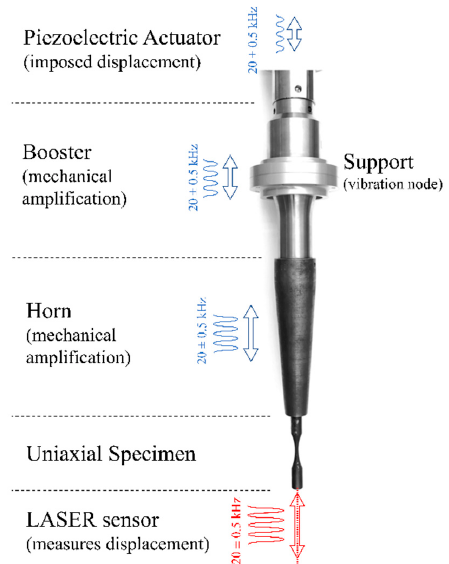
Figure 2. UFT machine resonant system components of one of the machines at Instituto Superior Técnico, University of Lisbon.